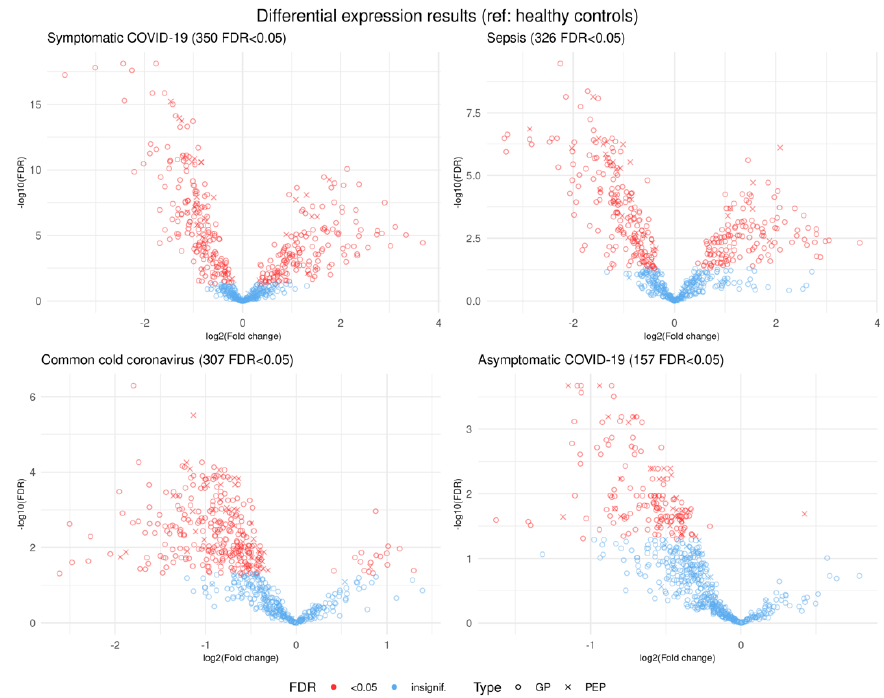
Figure 3. Volcano plots showing log-transformed multiplicative fold changes and respective log- transformed false discovery rates (FDRs) for each biomarker in differential expression analysis with healthy controls used as the reference for each phenotype. Biomarkers in red represent those that are statistically significantly differentially expressed at FDR < 0.05. Biomarkers marked with a circle are glycopeptides, while an X represents nonglycosylated peptides.